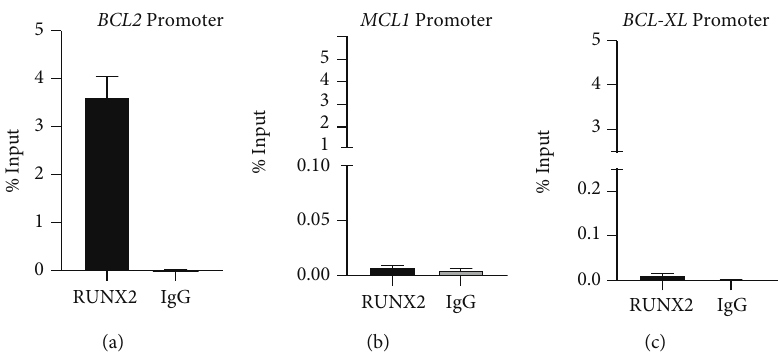
Figure 5: RUNX2 interacts with BCL2 proximal promoter in lung adenocarcinoma cell line A549. (a) Interaction of RUNX2 with the promoter of BCL2 gene. ChIP-qPCR assays were performed in lung adenocarcinoma cell line A549. ChIP assays con fi rm the interaction of RUNX2 protein with promoter region in lung adenocarcinoma. Promoters of MCL1 (b) and BCL-XL (c) were analyzed. Antibody against RUNX2 was used. Results are expressed as % input ± SEM using normal IgG as a speci fi city control. Results and statistical analyses were performed with respect to normal IgG (speci fi city control) (three independent